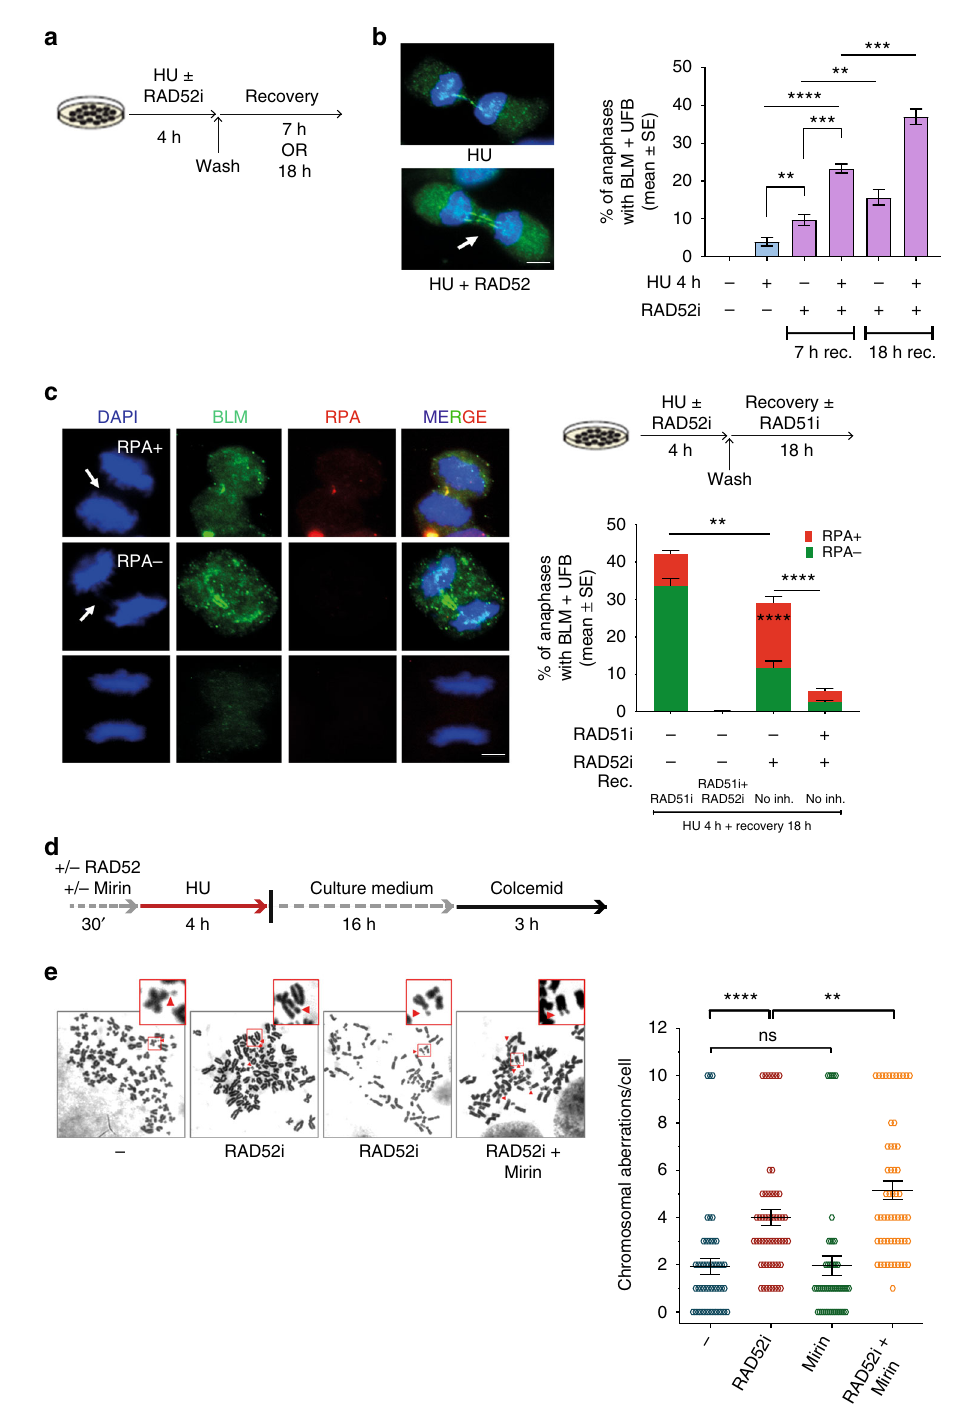
Fig. 8 Loss of RAD52 leads to enhanced genome instability. a Experimental scheme used for analysis of UFBs. b Quanti fi cation of BLM-positive UFBs in cells treated as in a . The graph shows the percentage of anaphases with BLM-positive UFBs. Representative images of anaphase cells with BLM-positive UFB (green) are shown on the right. (** P <0.1; *** P < 0.001; **** P < 0.0001; Mann – Whitney test; N = 50). c Analysis of UFBs in cells treated as shown in the experimental scheme on the top. Quanti fi cation of anaphase/telophase cells with BLM/RPA-positive UFBs. The graph shows the percentage of anaphases with BLM-positive UFBs. Representative images of an anaphase cell stained with BLM (green) as control, RPA (red), and DAPI (blue) are shown in the bottom of the panel. Minimum of 50 ana/telophase cells were scored per experiment; arrows indicate position of UFB. (** P < 0.01; **** P < 0.0001; Mann – Whitney test). d , e Analysis of chromosomal aberrations in cells treated as shown in the experimental scheme. Dot blot shows the number of chromosomal aberrations per cell. Data are presented as means of three independent experiments. Horizontal black lines represent the mean ± SE (ns not signi fi cant; ** P < 0.01; **** P < 0.0001; two-tailed Student ’ s t -test; N = 57). Representative images of Giemsa-stained metaphases are given. Arrows indicate chromosomal aberrations. Insets show an enlarged portion of the metaphases for a better evaluation of chromosomal aberrations. Scale bar represents 5 µ m. Source data are provided as a Source Data fi